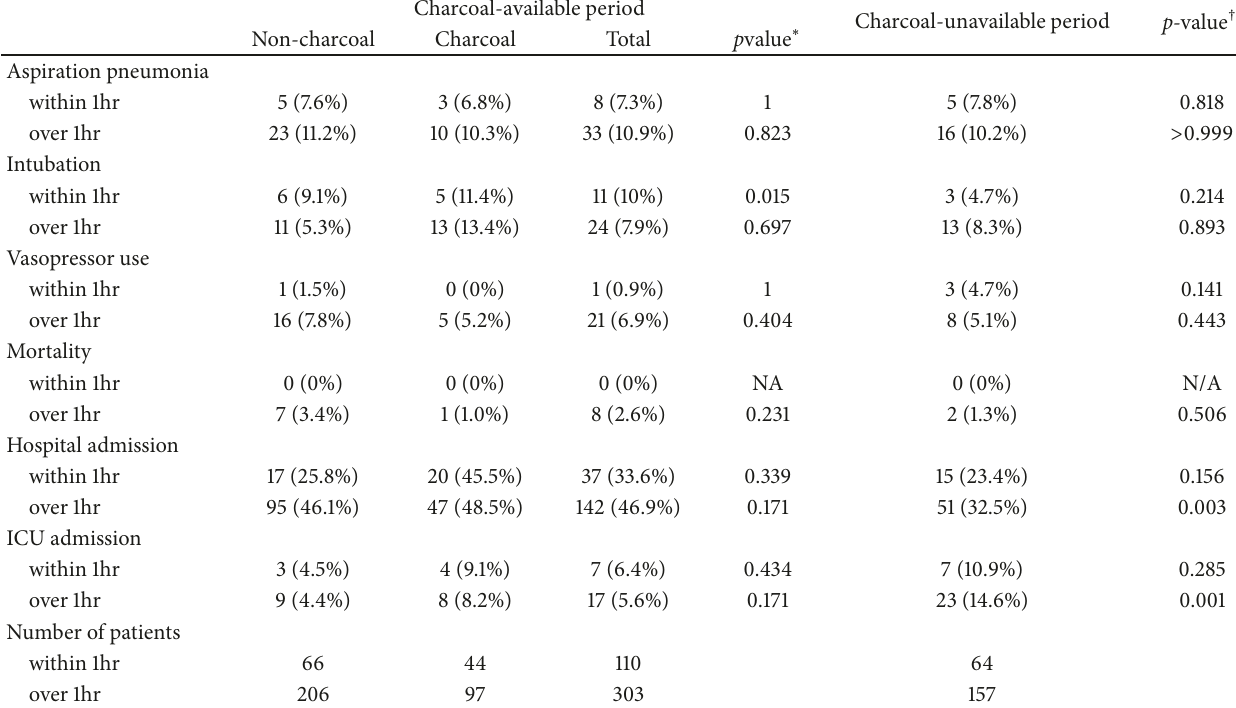
Table 6: Time delay from drug ingestion to ED visit and clinical outcome between charcoal-available and charcoal-unavailable periods. Charcoal-available period Charcoal-unavailable period